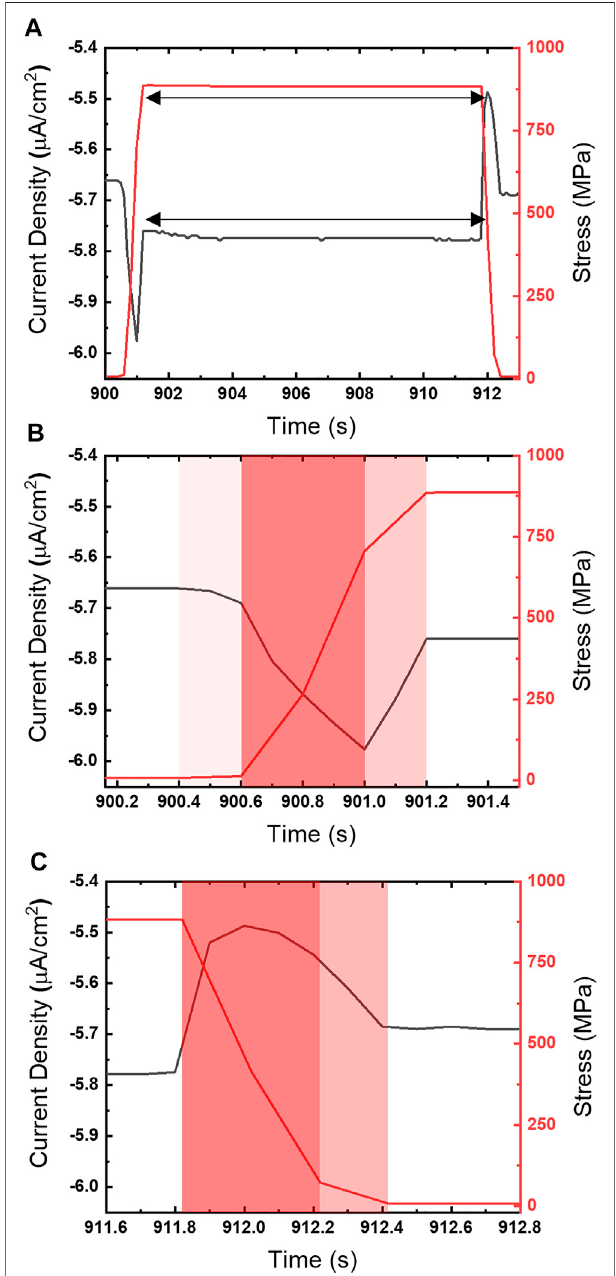
FIGURE 4 | (A) Chronoamperogram (left ordinate) overlaid with stress pro fi le (right ordinate) for UNS S13800 under 25 μ l of 4.6 M NaCl at 25 ° C and 80% RH at − 0.50 V SCE . The current response and stress pro fi le to (B) tensile and (C) compressive ramping are also shown on a fi ner time scale. The nominal strain rate during ramping is